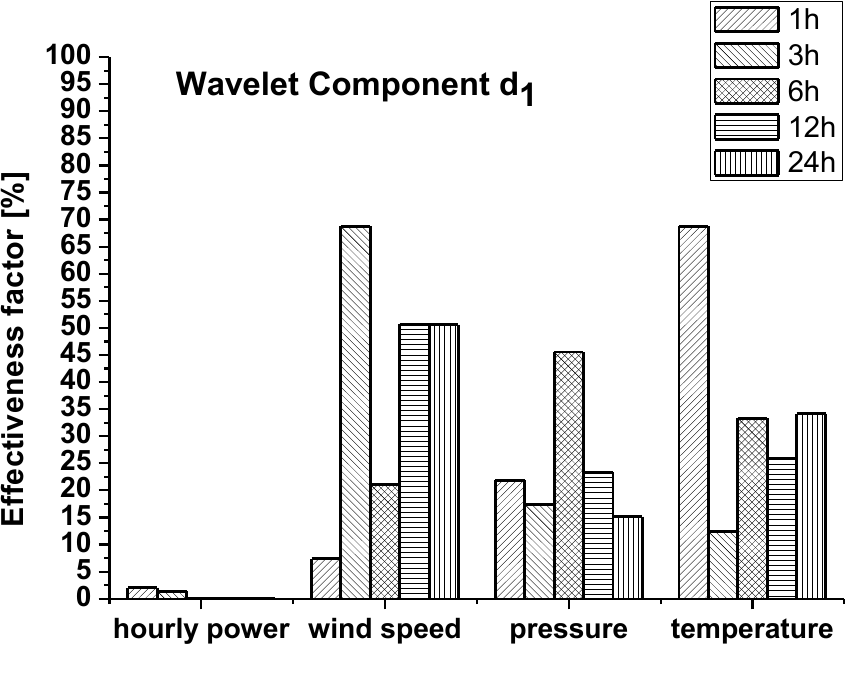
Figure 14. Histogram of the effectiveness factors for the detail component d